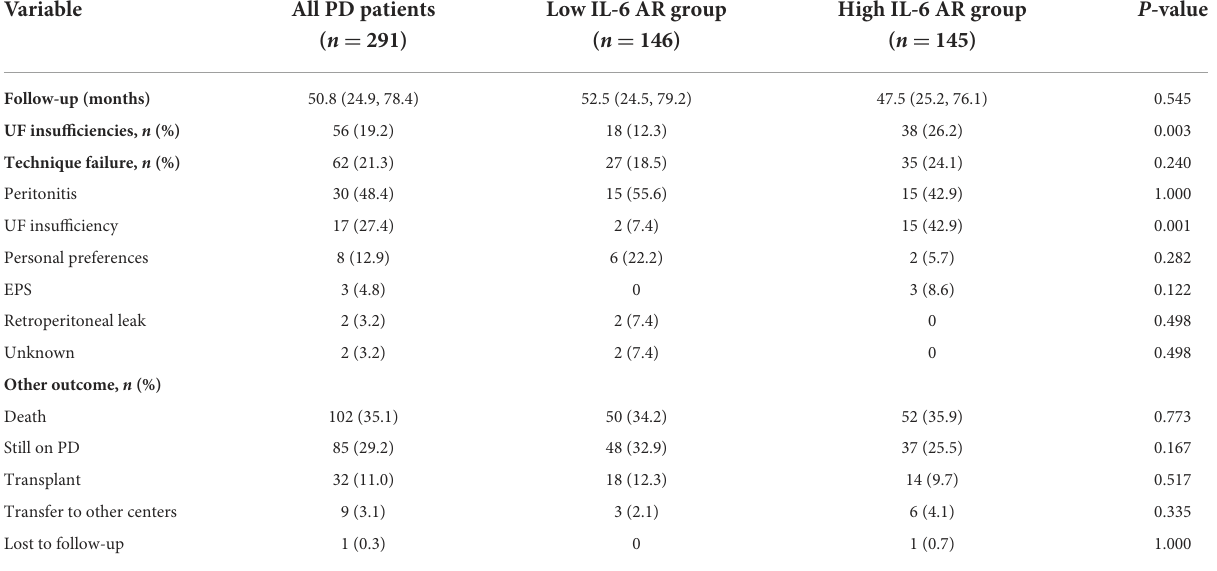
TABLE 4 Follow-up and outcome events in the patients by IL-6 AR.